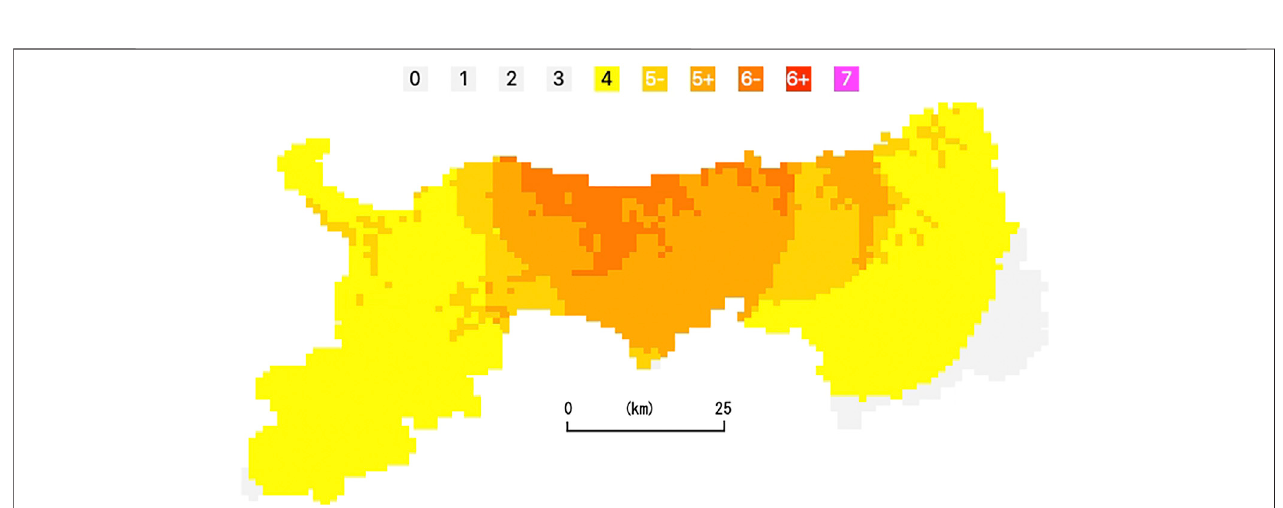
FIGURE 2 | Final seismic intensity distribution of the 2016 Central Tottori Prefecture Earthquake by the PLUM method with maximum values preserved.